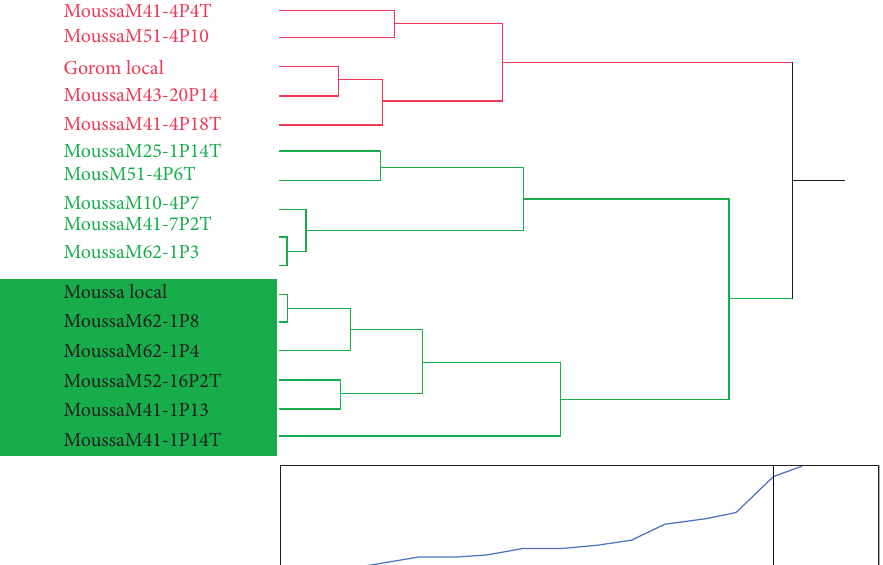
Figure 6: Dendrogram showing the two clusters based on MP, STI, TOL, SSI indices and yield of the tested